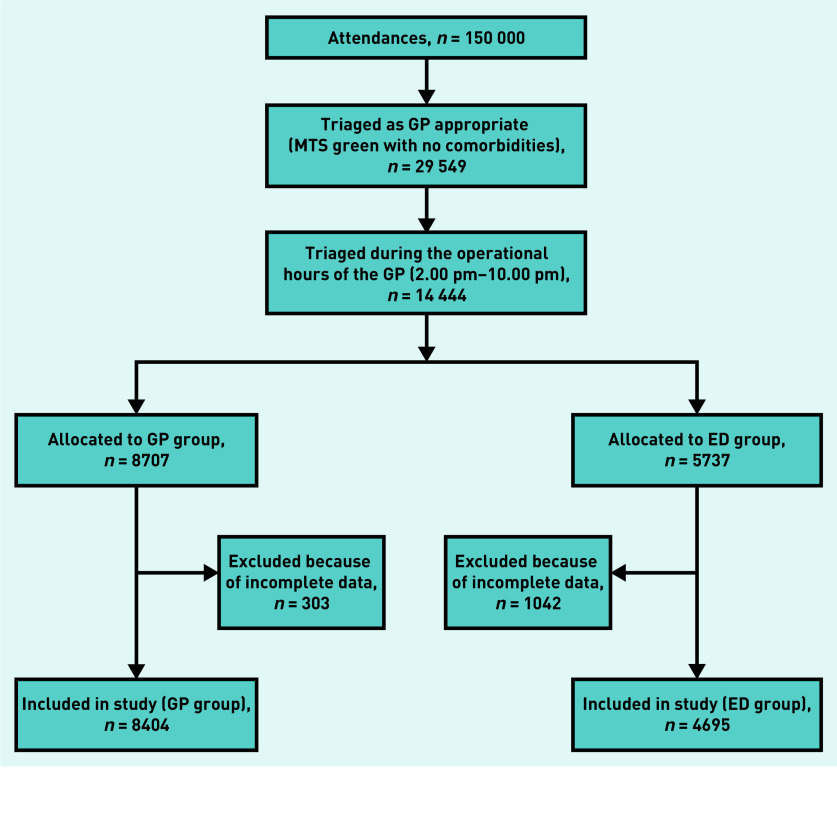
Study recruitment process.ED = emergency department. MTS = Manchester Triage System.